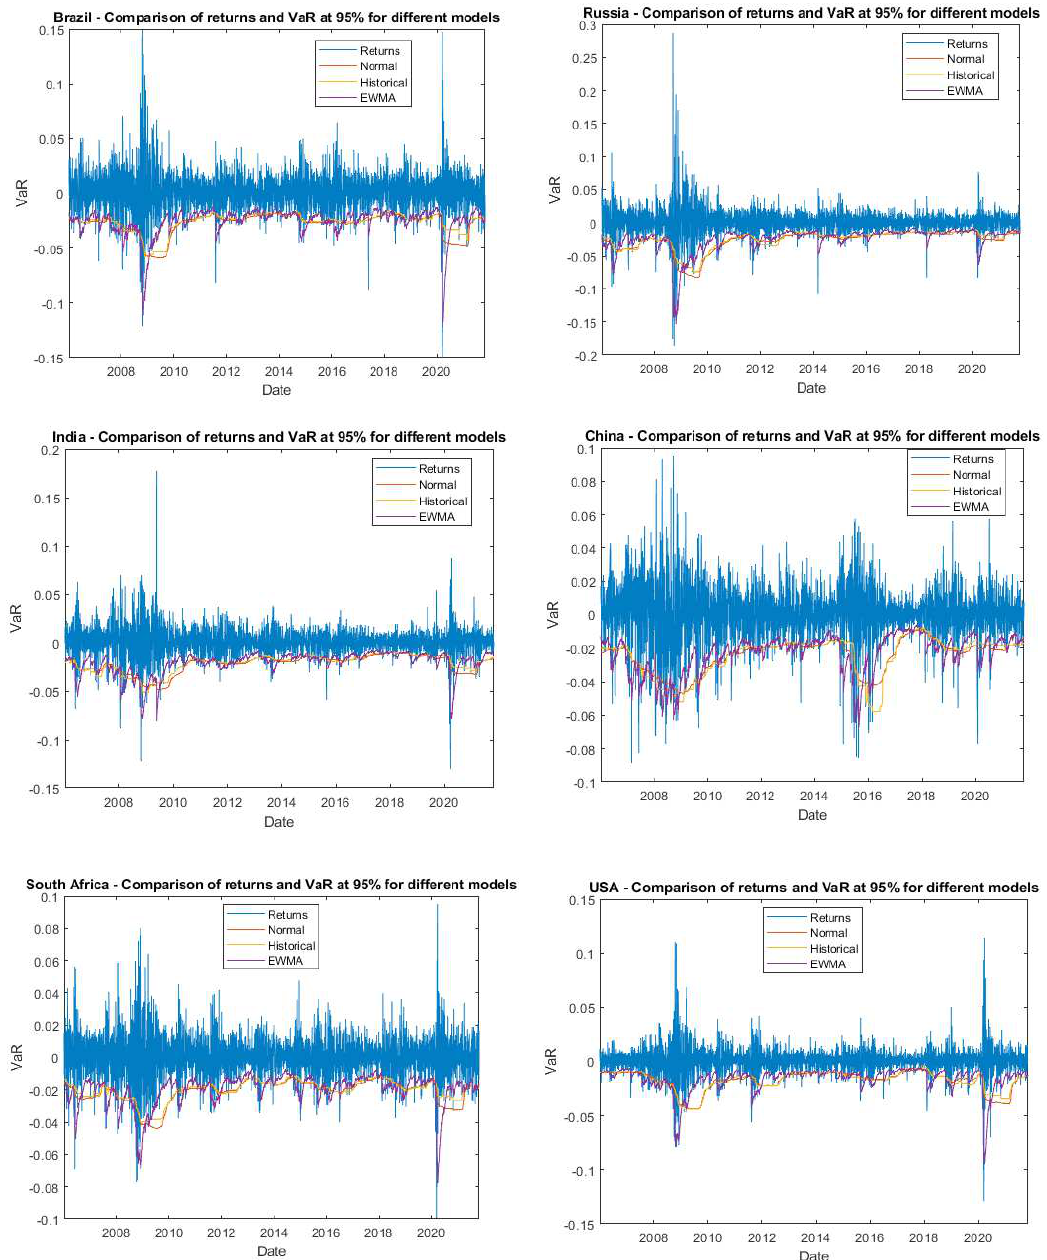
Figure 1. Comparison of returns and VaR at 95% for different models